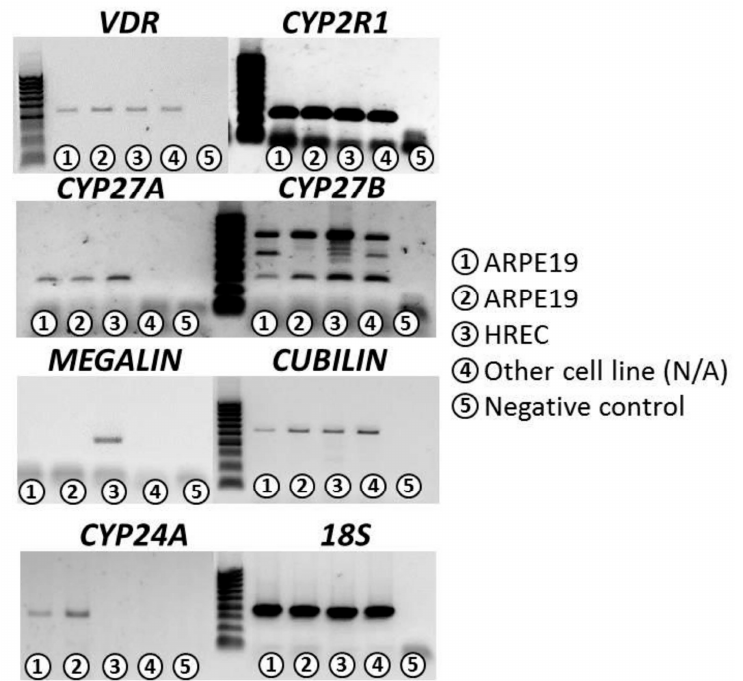
Figure 1. Conventional PCR was carried out using total RNA extracted from ARPE-19 (lines 1 and 2) and HREC cells (line 3). We analyzed the gene expression of VDR , CYP27B1 , CYP24A1 , CYP27A1 , CYP2R1 , cubilin , and megalin . Ribosomal 18S was used as an internal PCR control. Results are representative of at least three independent experiments. Molecular sizes (base pairs [bp]): 18S (400),